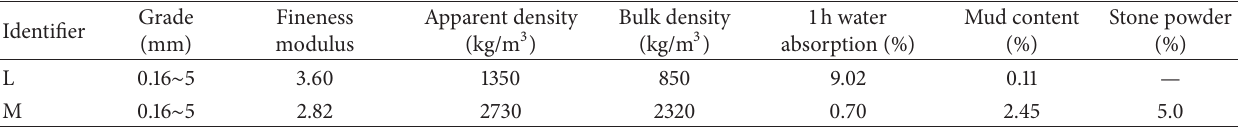
Table 4: Physical properties of lightweight sand and manufactured sand.